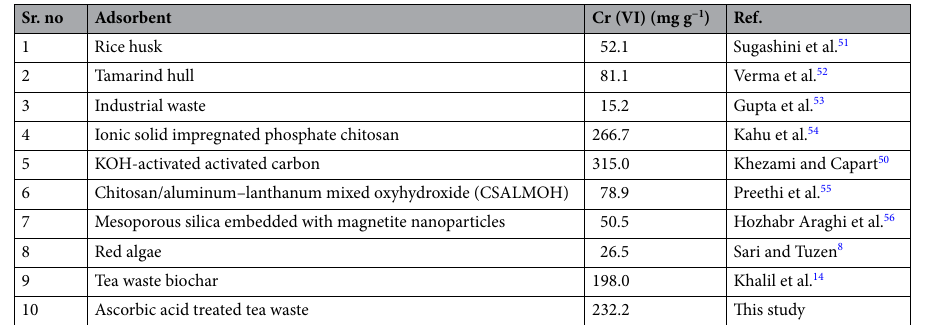
Table 5. Comparison of adsorption of Cr(VI) with other adsorbents.